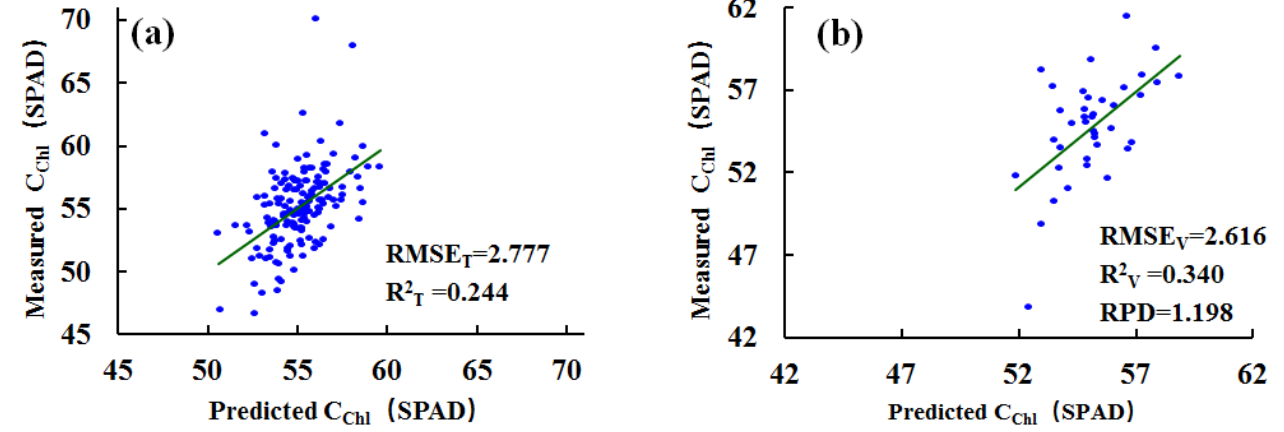
Figure 13. The estimated results of SPAD value for ( a ) training set and ( b ) validation set based on pretreatment ND-(1/R)’-PCADR at filling